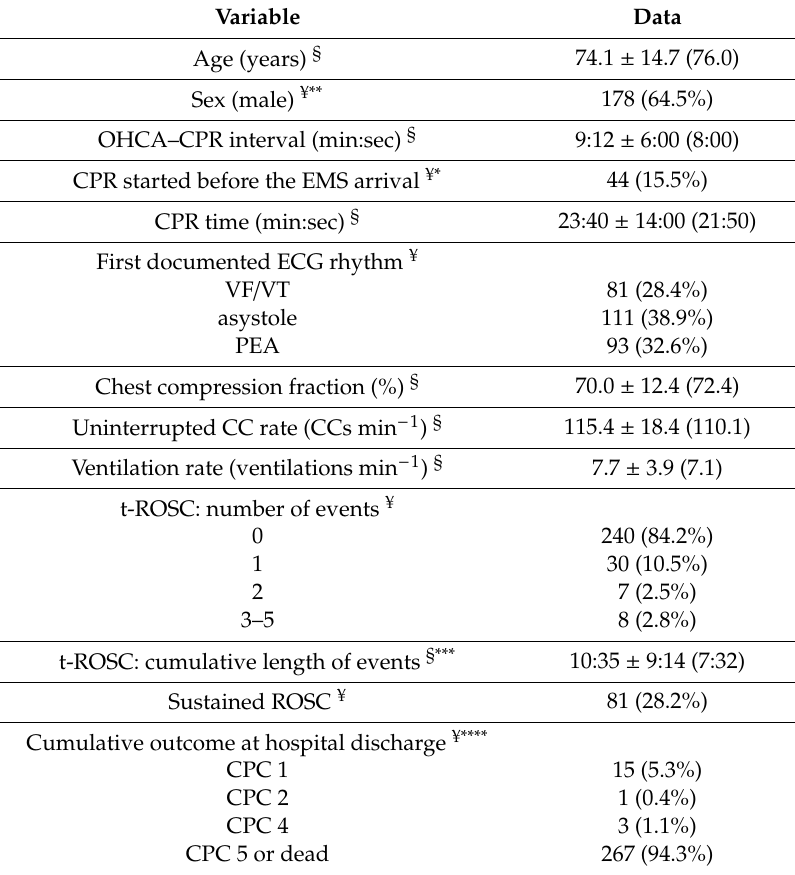
(Table 5). Hosmer-Lemeshow test suggested that the model had a good fit ( χ 2 = 1.550; p = 0.992). Table 2. Main characteristics of the study population.